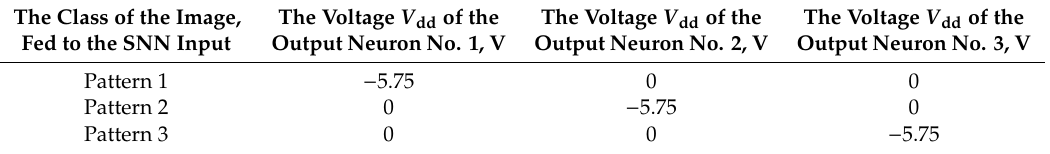
Table 1. An example of the supply voltage setting V dd of the output layer, using the supervised learning method in SNN training.